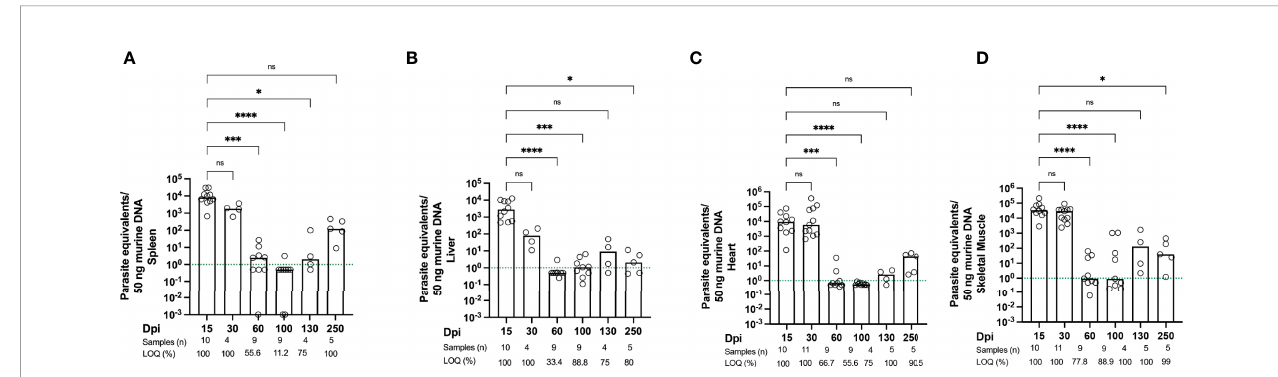
FIGURE 1 | Kinetics of parasite load con fi rm that T. cruzi persists in skeletal muscle. Parasite tissue burden was determined by qPCR. Parasite equivalents per 50 ng DNA were analyzed between 15 dpi (acute phase) and 800 dpi (chronic phase). (A) Spleen, (B) liver, (C) heart and (D) sk. muscle (n ≥ 4-23 mice per group). Parasite loads below the limit of quanti fi cation (LOQ) were set to LOQ/2, i.e. 0.5 parasite equivalents per 50 ng of DNA. The green dotted line indicates the limit of quanti fi cation, which means that samples below this line are still positive, but the parasite load cannot be quanti fi ed accurately. 10 -3 is the limit of detection, as described in Methods. Data were compared using the Kruskal-Wallis test and Dunn ’ s multiple comparison test. All data are representative of 10 independent experiments. Values are presented as mean. *p < 0.05, ***p < 0.001, ****p < 0.0001, n.s. not signi fi